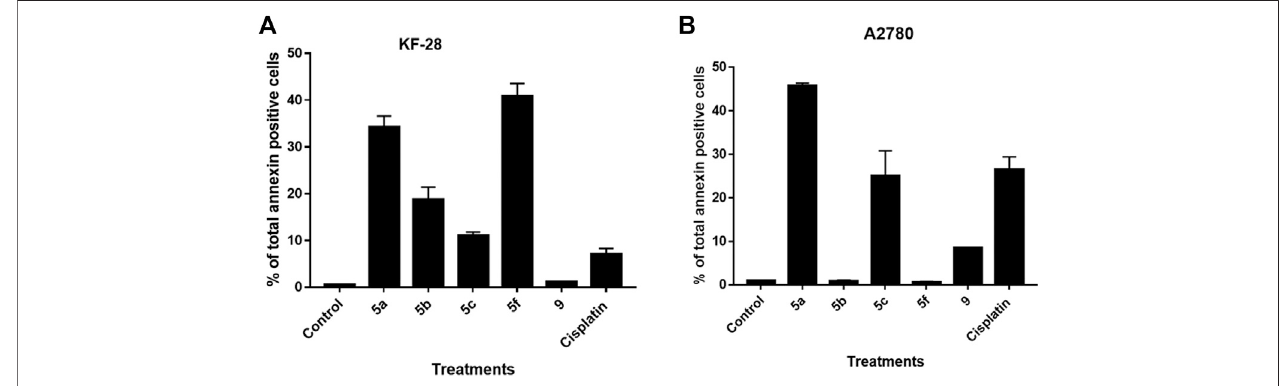
FIGURE 2 | Some compounds induce apoptosis in KF-28 and A2780 cells. Average percentage of annexin-positive cells from KF-28 (A) and A2780 (B) cells treated with DMSO and different compounds, 5a, 5b, 5c, 5f, and 9, in parallel with the standard drug, cisplatin (10 μ M), treatment for 48 h. Values are presented as mean ±